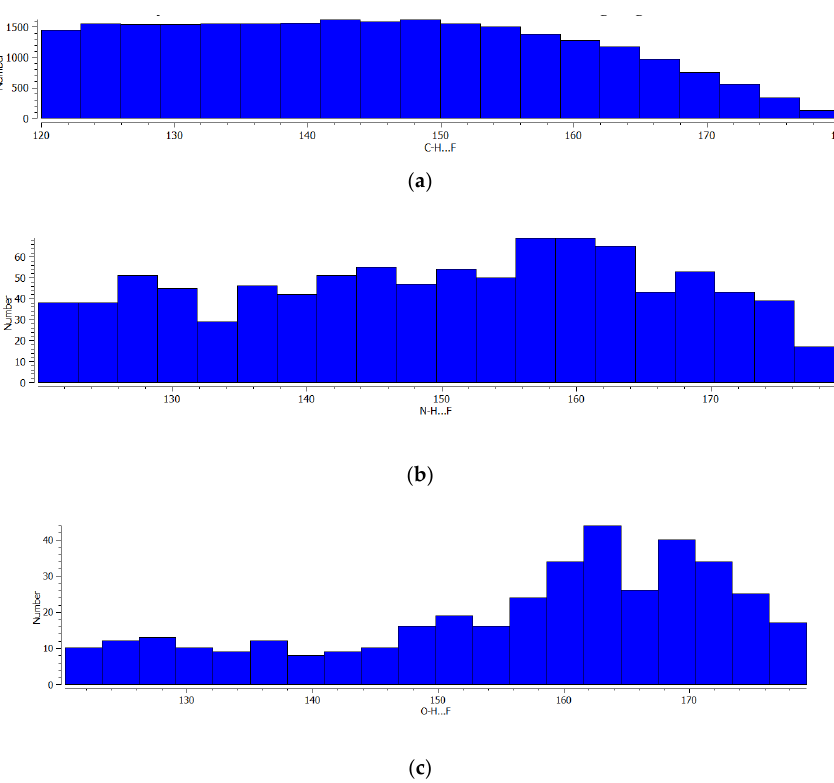
Figure 3. The histograms of the A-H ... F angles for systems of three samples taken from CSD and considered in this study ( a ) A = C, ( b ) A = N and ( c ) A = O.